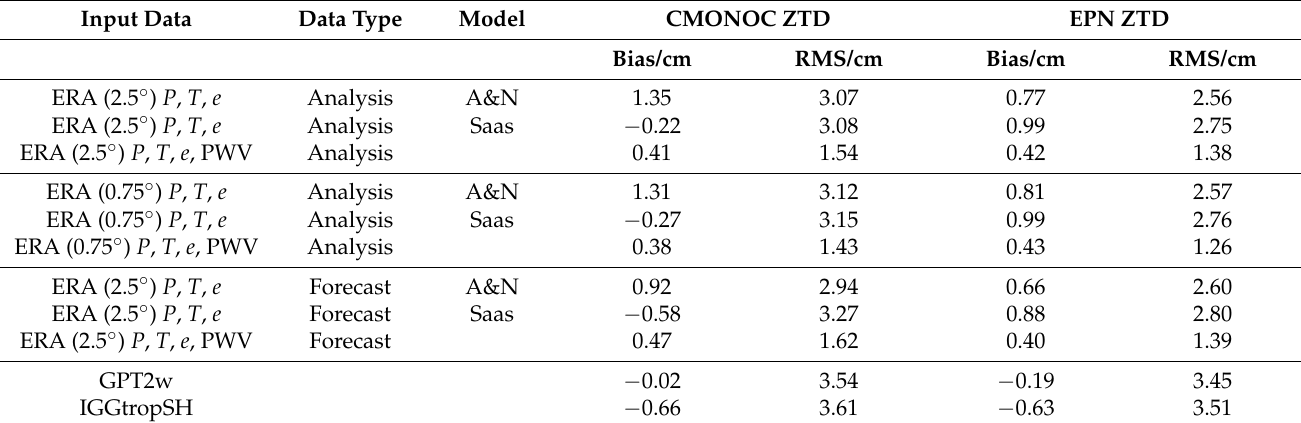
Table 7. Statistics of mean accuracies of ZTDs calculated from ERA surface data and two empirical tropospheric models, GPT2w and IGGtropSH, with GNSS-ZTDs over 302 CMONOC stations and GNSS-ZTDs over 302 EPN stations during 2015 as references,